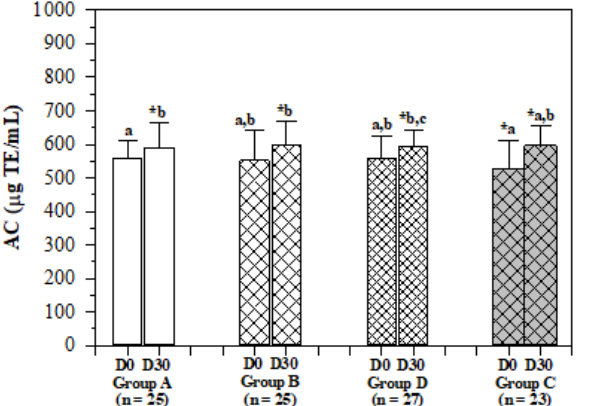
Figure 5. Changes in levels of serum antioxidant capacity of elderly subjects. Non-anemic elders consumed the WR drink (2 mg iron/100 mL serving) (group A), IR drink (15 mg iron/100 mL serving) (group B) and IR drink (27 mg iron/100 mL serving) (group D), while anemic elders consumed the IR drink (15 mg iron/100 mL serving) (group C) for 30 days and blood samples were collected for analysis of antioxidant capacity. Data are expressed as mean ± SD values with the exception of ferritin, which is expressed as mean + standard error of the mean (SEM). * Shapiro – Wilk test ( p < 0.05). a,b,c Comparisons between D0 and D30 for non-normal distribution by Wilcoxon signed rank test ( p < 0.05) after applying the Friedman test ( p < 0.05). Abbreviations: AC = antioxidant capacity,